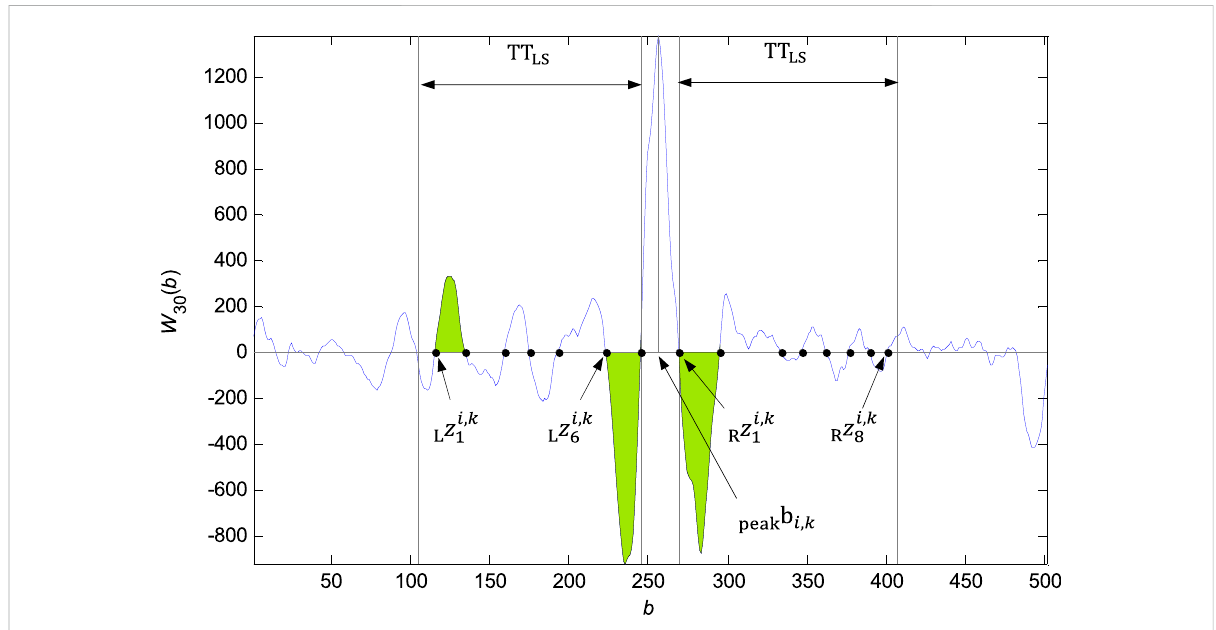
FIGURE 6 Founded zero points L z i , k s to the left of the peak b i , k and R z i , k t to the right of the peak b i , k in the TT LS bounds. The zero points met the condition corresponding to the green denoted intervals and the elements {